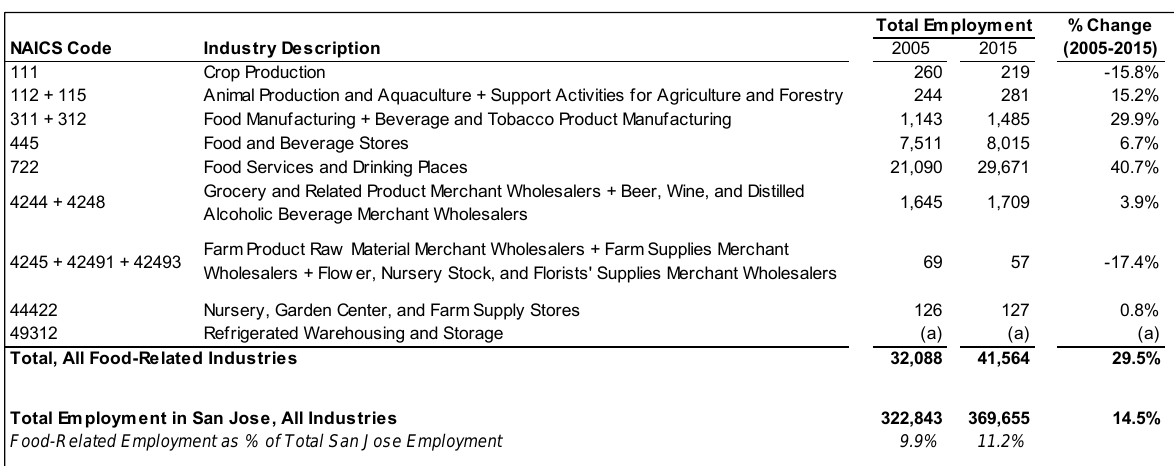
Table 2. Food-Related Employment in San Jose, 2005–2015